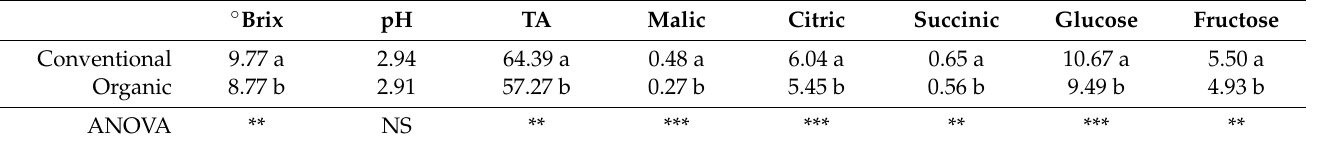
Table 4. Total soluble solids ( ◦ Brix), pH, total titratable acidity (TA; g citric acid L − 1 ), organic